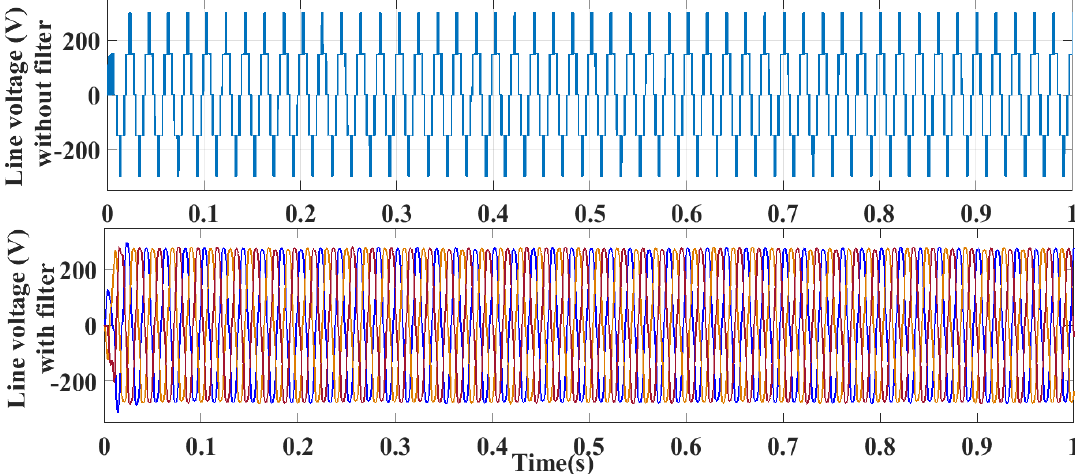
Figure 13. Line voltage of inverter with and without filter.